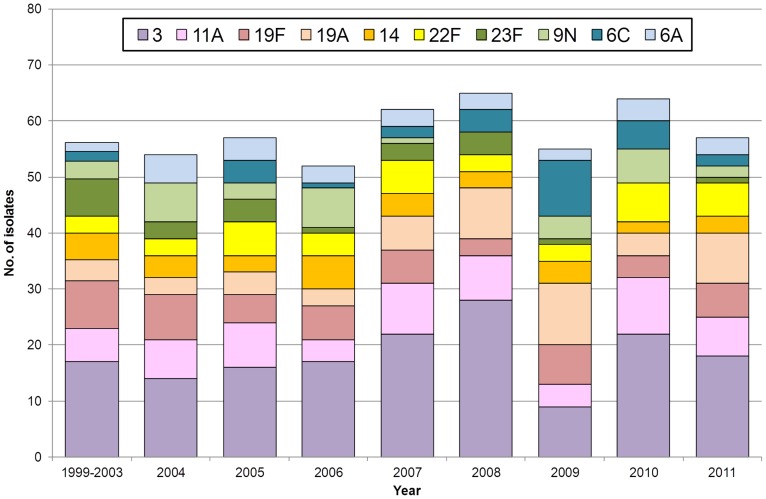
Serotype distribution of the isolates causing non-invasive pneumococcal pneumonia in adults in Portugal (1999–2011).Only the overall 10 most frequent serotypes are shown. The other serotypes found between 1999 and 2011 were serotypes 6B, 7F and 15A (n = 32, each), 23B (n = 30), 15B (n = 28), 10A (n = 27), 9V and non-typable (n = 26, each), 23A (n = 24), 1 (n = 22), 8 (n = 20), 16F (n = 19), 29 (n = 18), 4 (n = 17), 31 (n = 16), 34 (n = 15), 18C (n = 14), 17F and 33A (n = 13, each), 21 and 35F (n = 11, each), 15C and 35C (n = 10, each), 20 (n = 9), 12B and 17A (n = 8, each), 13, 25F and 25A/38 (n = 7, each), 7C and 28A (n = 5, each), 5 (n = 4), 11F, 18A and 19C (n = 3, each), 12A, 12F, 35A, 35B, 38 (n = 2, each) and 9L, 10F, 15F, 16A, 19B, 33F, 39 and 42 (n = 1, each). The value shown for 1999–2003 refers to the yearly average of the 500 isolates studied that were isolated in these 5 years. This period was analyzed together since previously published IPD data indicated that these corresponded to a pre-PCV7 serotype distribution [14].